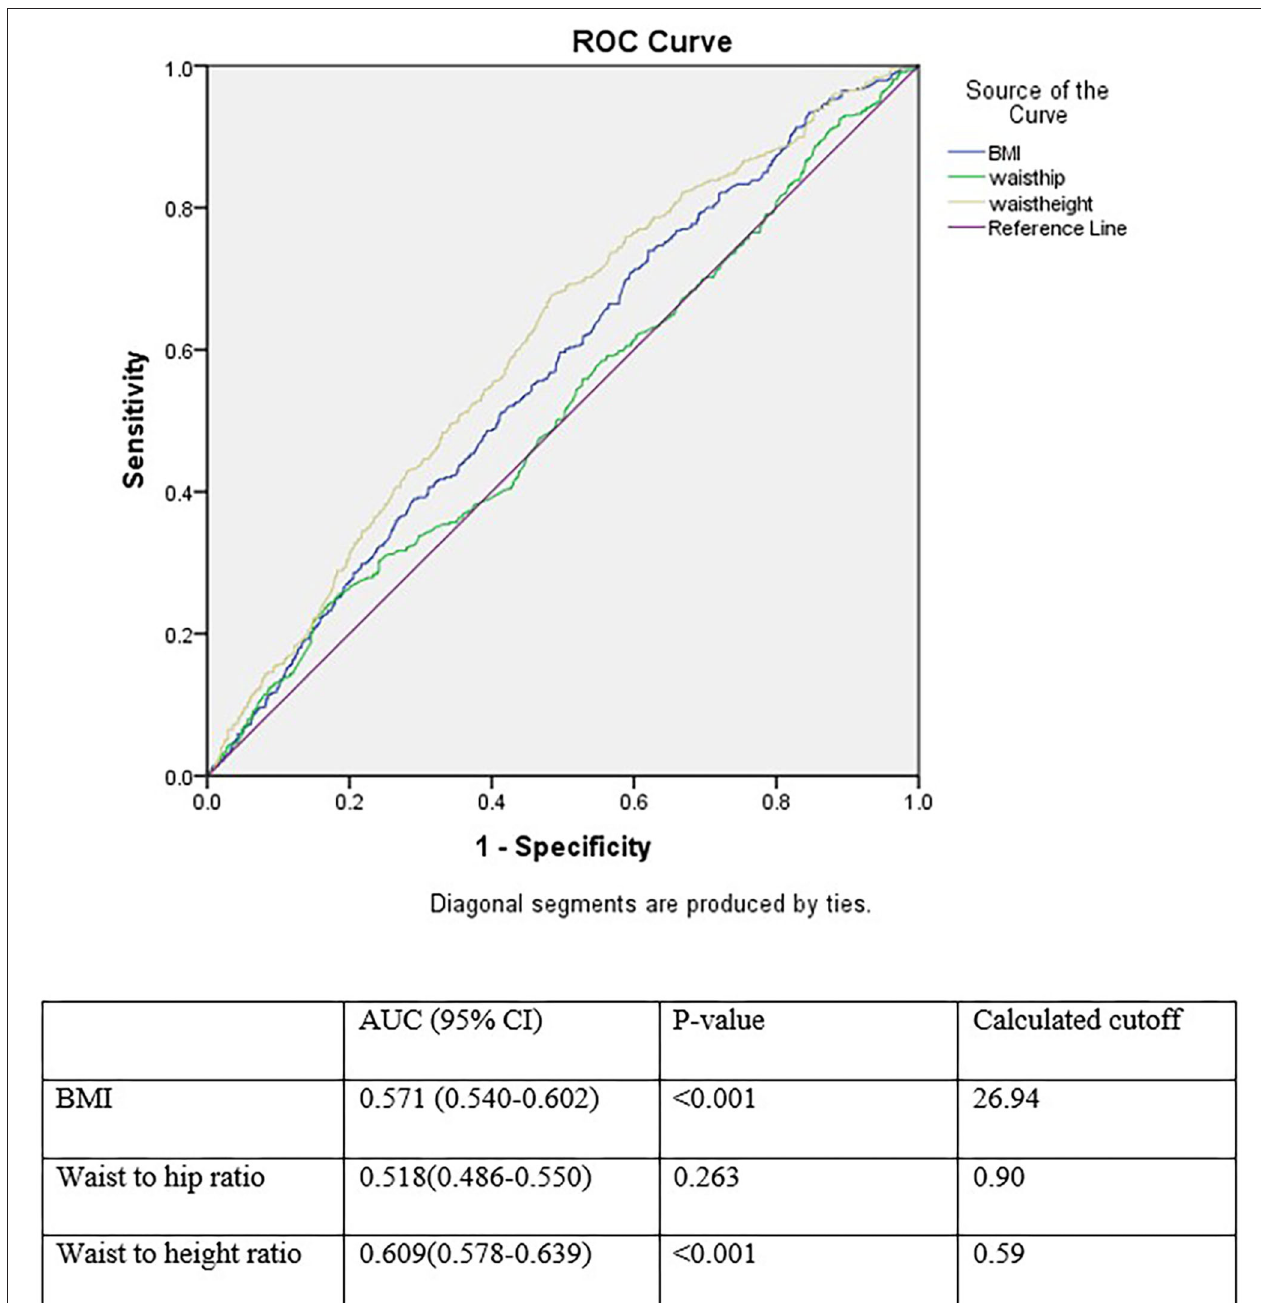
FIGURE 2 | Receiver operating characteristics curve analysis for comparison of BMI, waist to hip ratio, and waist to height ratio as an index for incident hypertension.